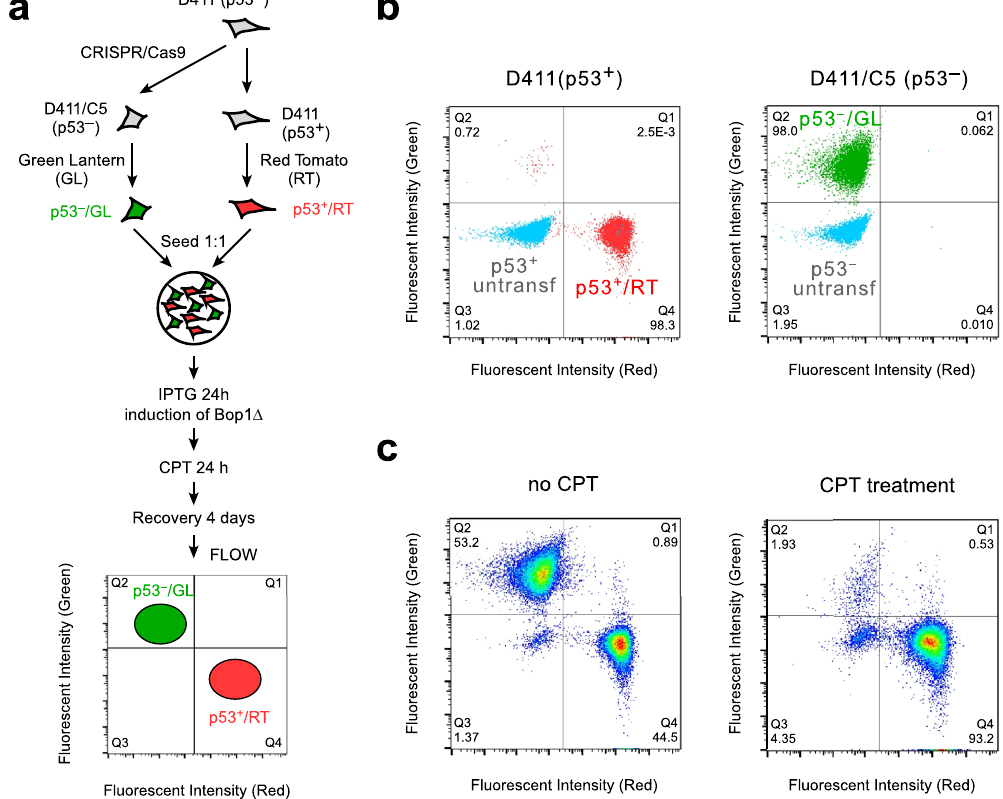
Figure 5. The combination of nucleolar stress and CPT leads to selective depletion of p53-negative cells from a mixed cell population. ( a ) A cell model to test the combination of a transient nucleolar stress with the CPT treatment in isogenic p53 + and p53- cells. ( b ) Flow cytometry plots of D411 (p53 + ) cells and D411/C5 (p53-) cells transfected with the red (RT) and green (GL) fluorescent markers, respectively. ( c ) Representative flow cytometry analysis of the mixed fluorescently labeled p53 + and p53- cells after induction of Bop1 Δ and 0.4 μ M CPT treatment indicates increased survival of RT-labeled p53 + cells relative to GL-labeled p53- cells. In the absence of Bop1 Δ induction, cells are killed by this concentration of CPT regardless of p53 status (see Fig.